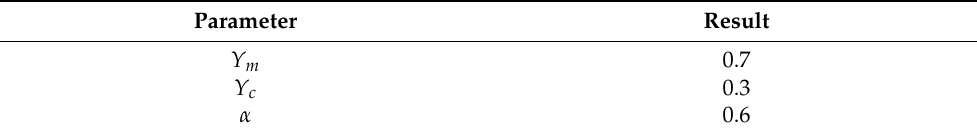
Table 1. Fitting results of the Y m , Y c , and α material constants.